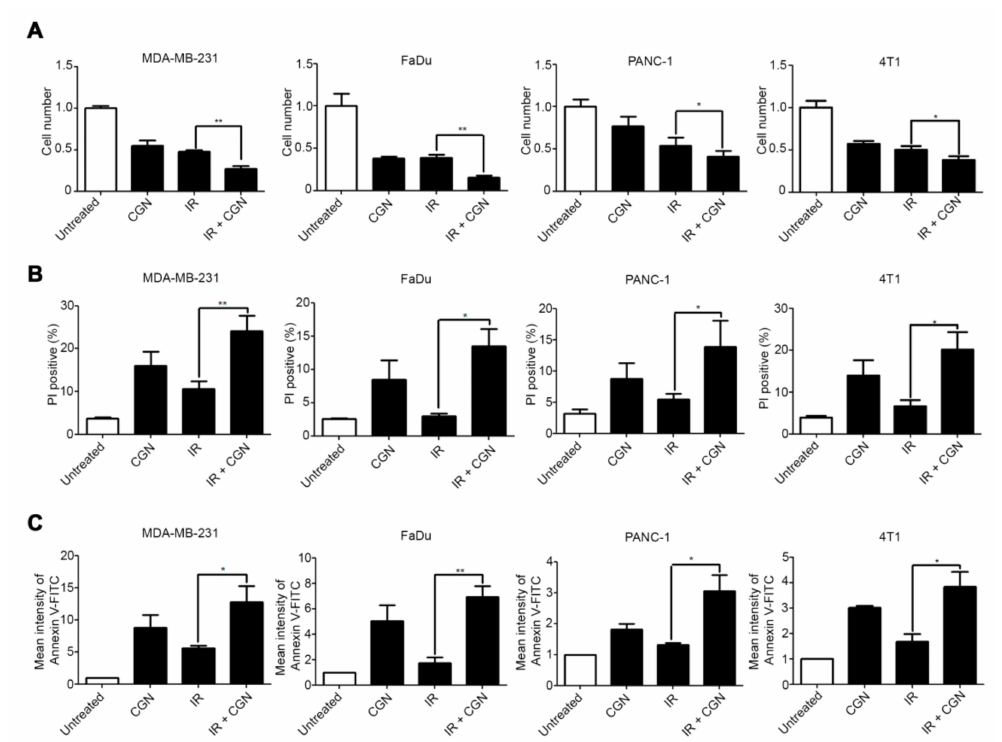
Figure 1. λ -carrageenan (CGN) treatment decreases cell viability and increases apoptosis in irradiated cancer cell lines. Cells were treated with 4 Gy IR, followed by CGN on the next day, and then analyzed 72 h after IR. ( A ) Cell viability was quantified by cell counting in MDA-MB-231, FaDu, PANC-1, and 4T1 cell lines. ( B ) The percentage of dead cells was measured by PI staining, followed by flow cytometry. The proportion of dead cells was quantified by gating the population of PI-positive cells. ( p -values: MDA-MB-231, 0.0056; FaDu, 0.0129; PANC-1, 0.0489; 4T1, 0.0468.) ( C ) Apoptotic cells were measured by Annexin V-FITC staining, followed by flow cytometry. Mean fluorescence intensity of FITC was calculated and normalized to the untreated group. Columns, mean ( n ≥ 3); bars, SE. *, p < 0.05; **, p <